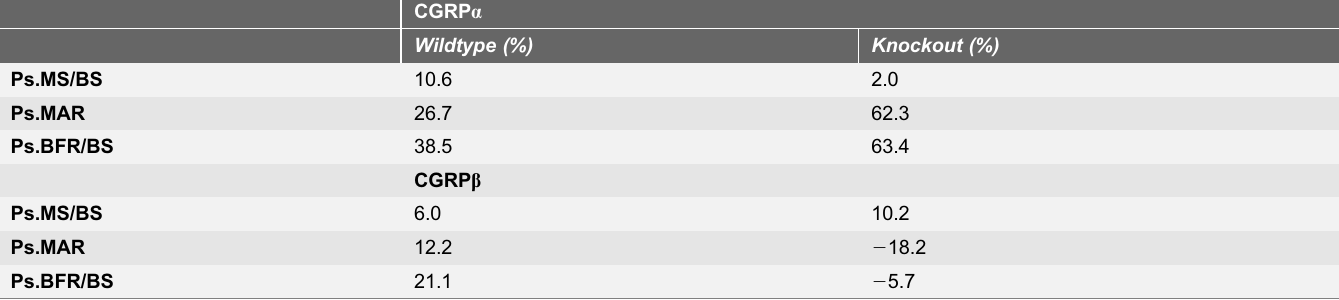
Table 1. Relative contributions of mineralizing surface and mineral apposition rate to load-induced periosteal bone formation in CGRP a and CGRP b wildtype and knockout